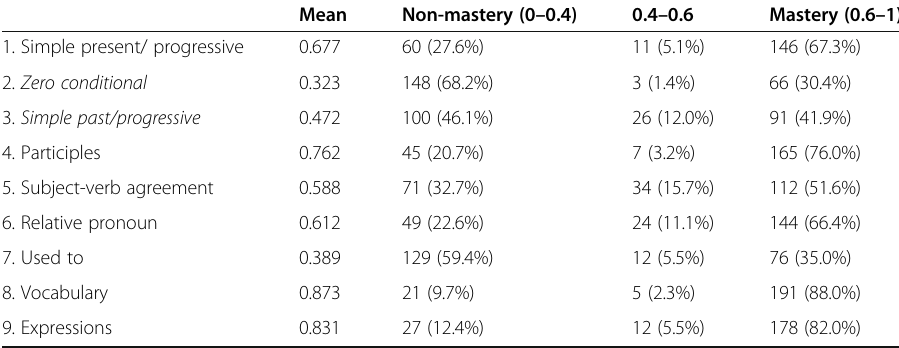
Table 8 Mean mastery probabilities and 217 examinee percentages on the second test